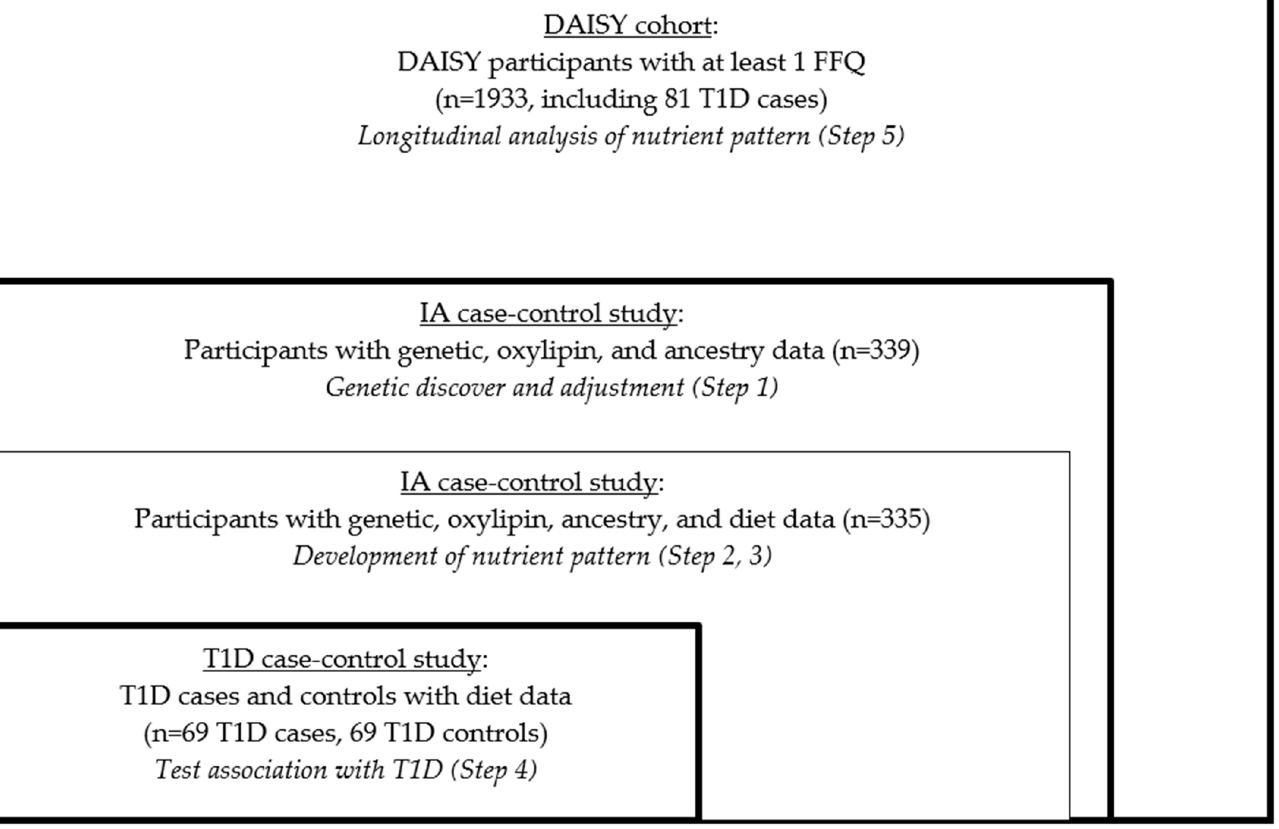
Figure 1. Study design and sample selection.